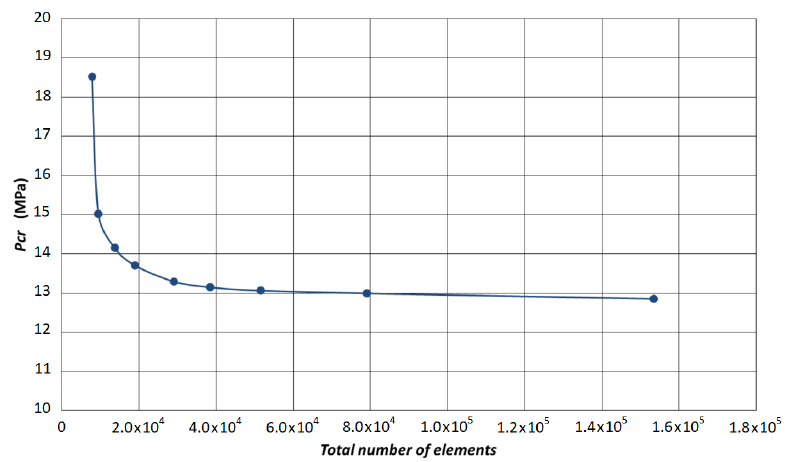
Figure 13. Convergence analysis for the shell with sliding stiffeners.